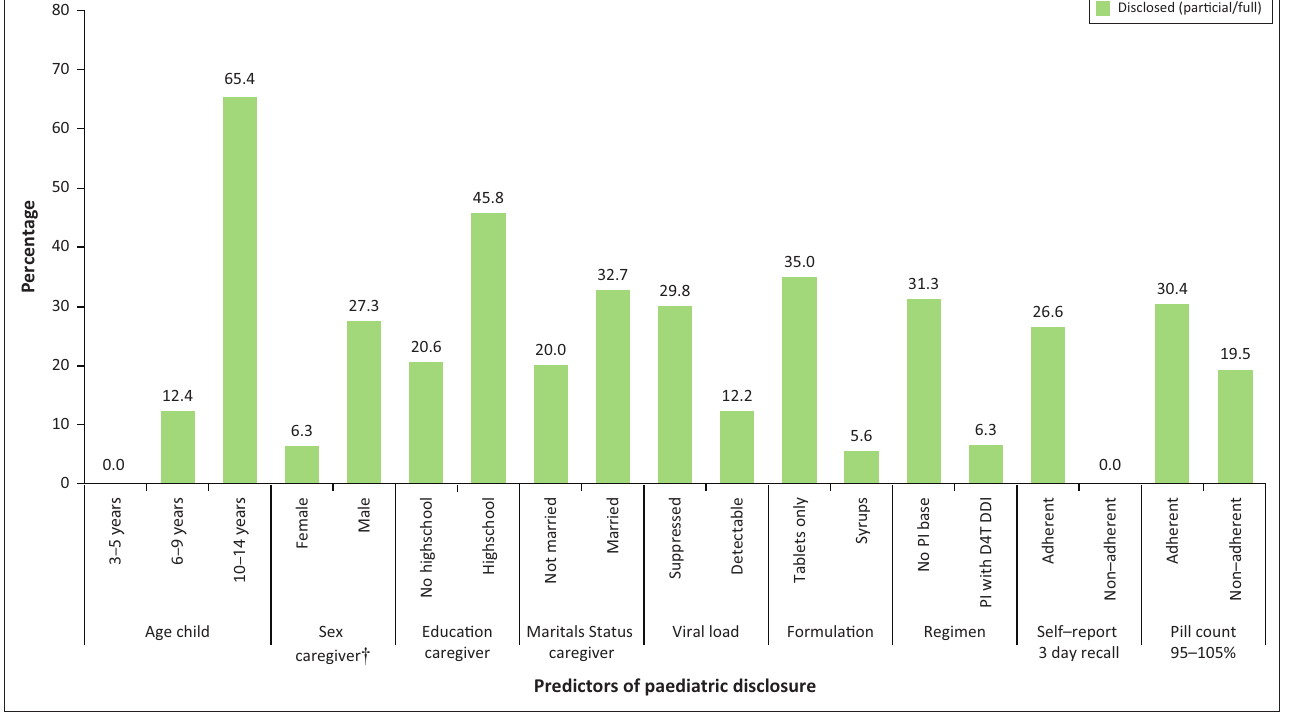
FIGURE 1 : Predictors of paediatric disclosure